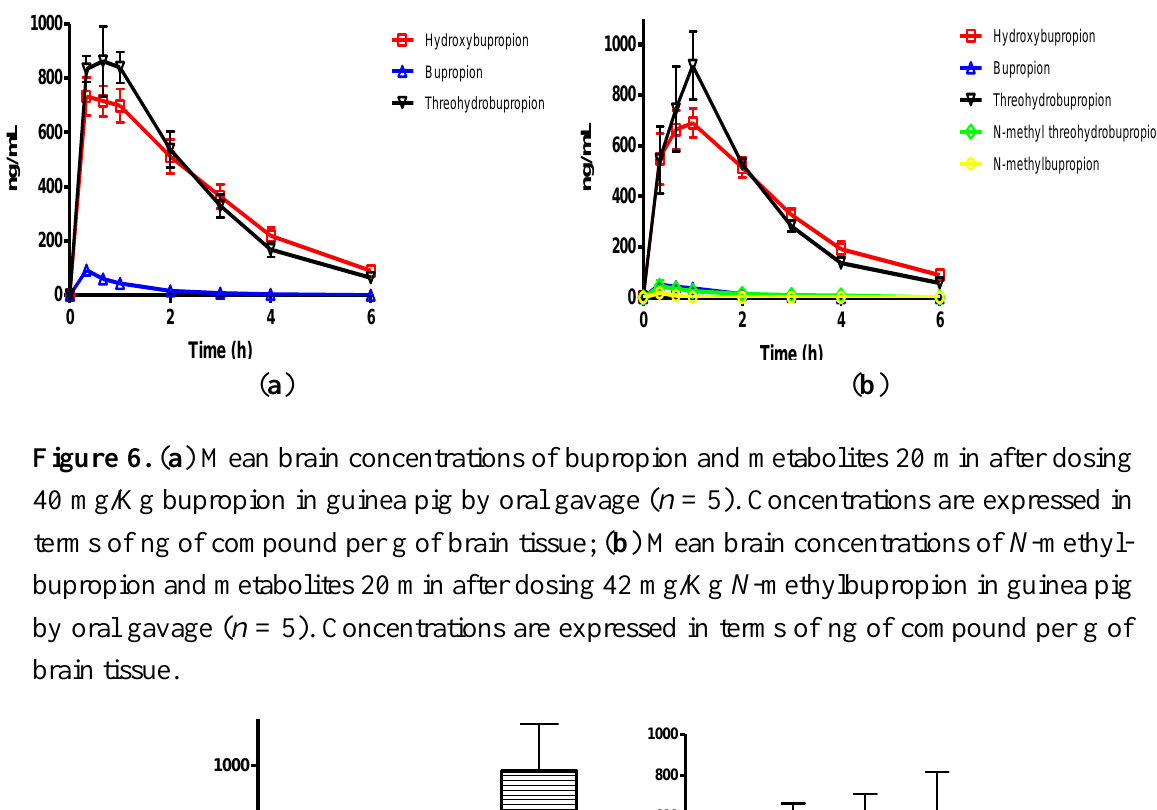
Figure 5. ( a ) The mean plasma concentrations of bupropion and selected metabolites after dosing 40 mg/Kg bupropion to guinea pigs by oral gavage ( n = 5); ( b ) The mean plasma concentrations of N -methylbupropion and selected metabolites after dosing 42 mg/Kg N -methylbupropion to guinea pigs by oral gavage ( n = 5).